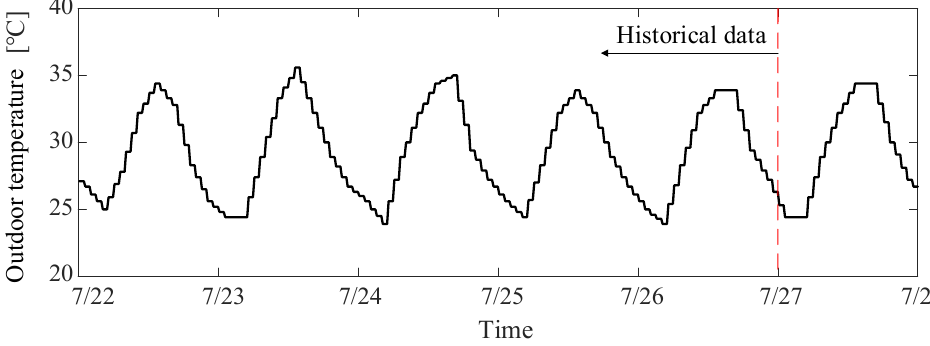
Figure 2. Solar irradiation profiles [25].